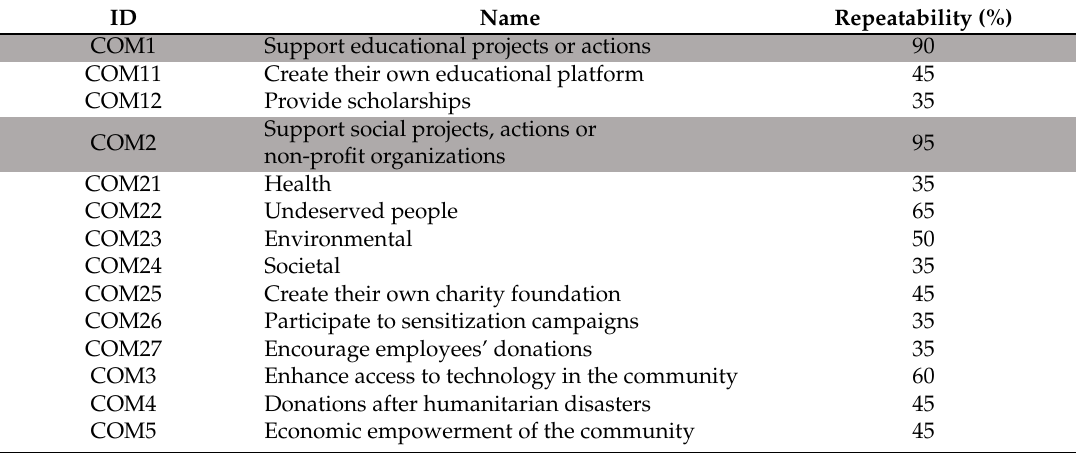
Table 4. Repeatability in percentage of each of the 36 evaluated strategies. (The lines in grey mean that the strategy reached the repeatability threshold we set